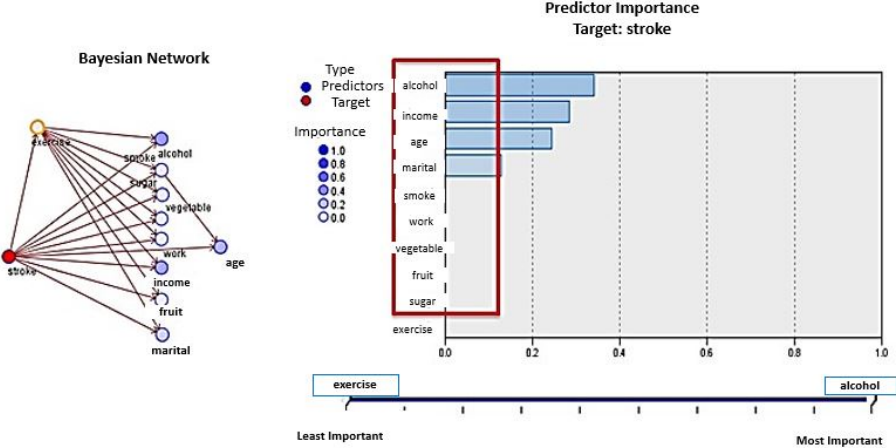
Figure 3. Bayesian Networks: Model summary and predictor importance.